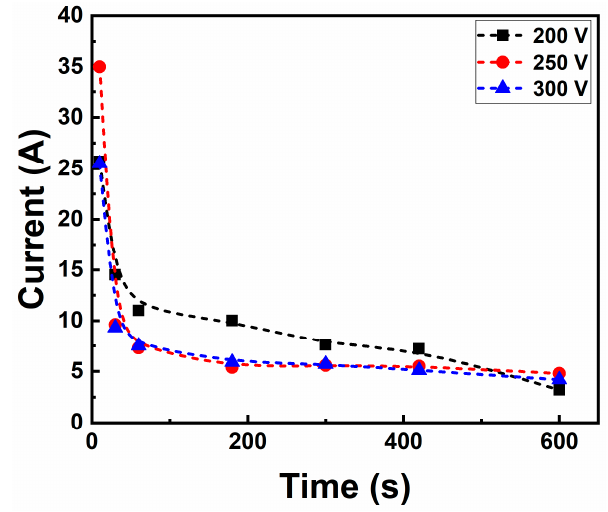
Figure 1. Current vs. time curves of the samples collected during the PEO treatments.